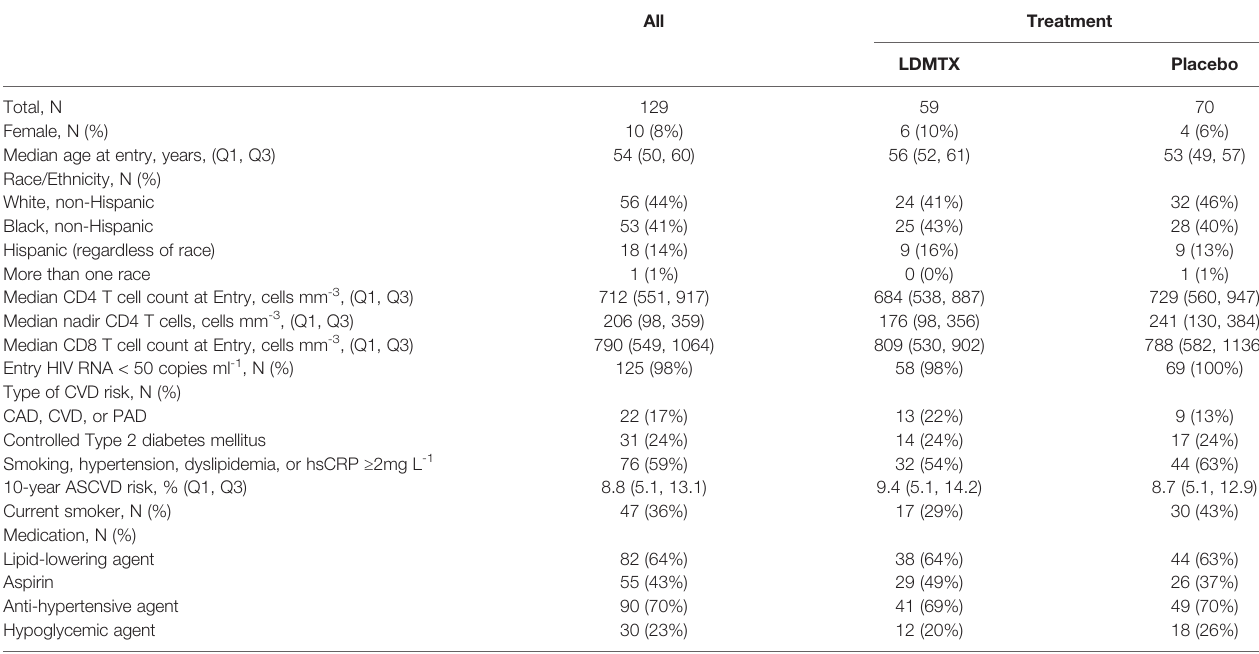
TABLE 1 | Participant